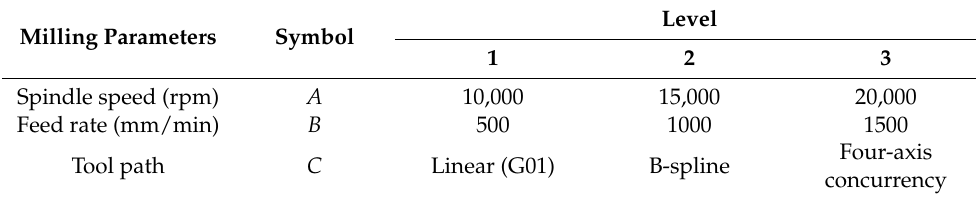
Table 8. Orthogonal array of the experimental factors and levels.